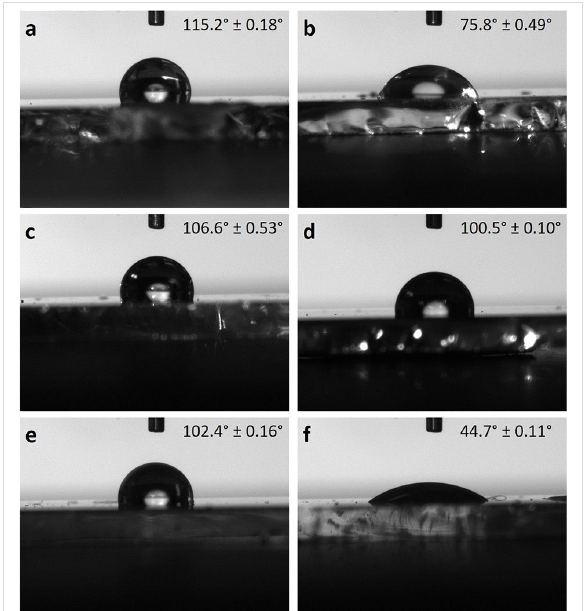
Figure 10: Water contact angle measurements on (a) 200 nm Ag, (b) 200 nm Ag + 15 min hydrogen plasma